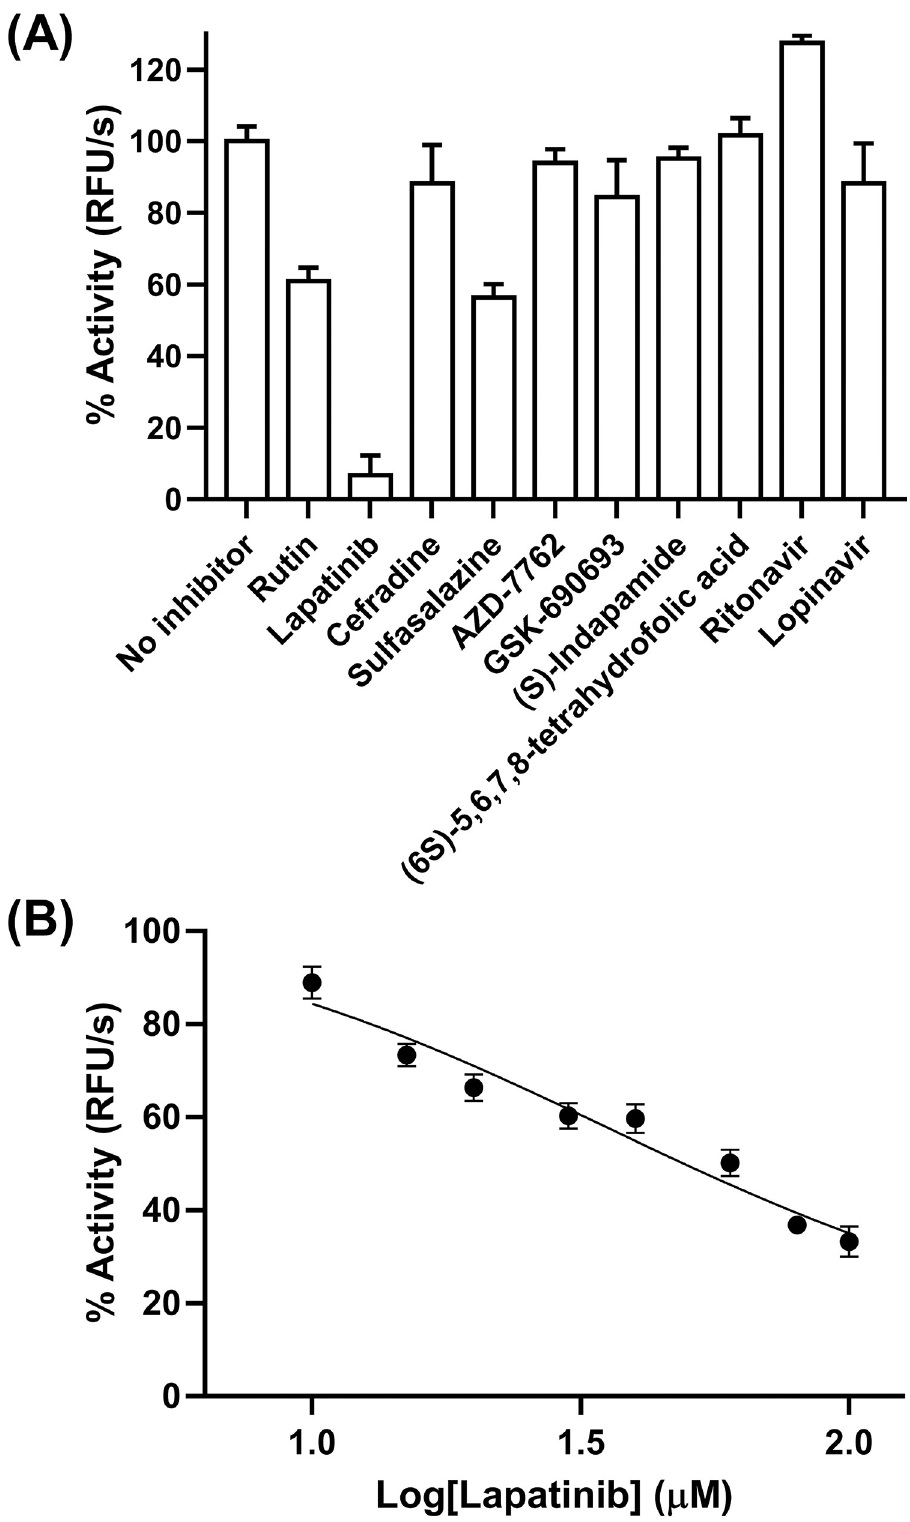
Fig 5. In vitro enzymatic studies. (A) Relative activity of 3CL pro in the presence of 100 μ M of compounds and (B) inhibition of 3CL pro by lapatinib at various concentrations.